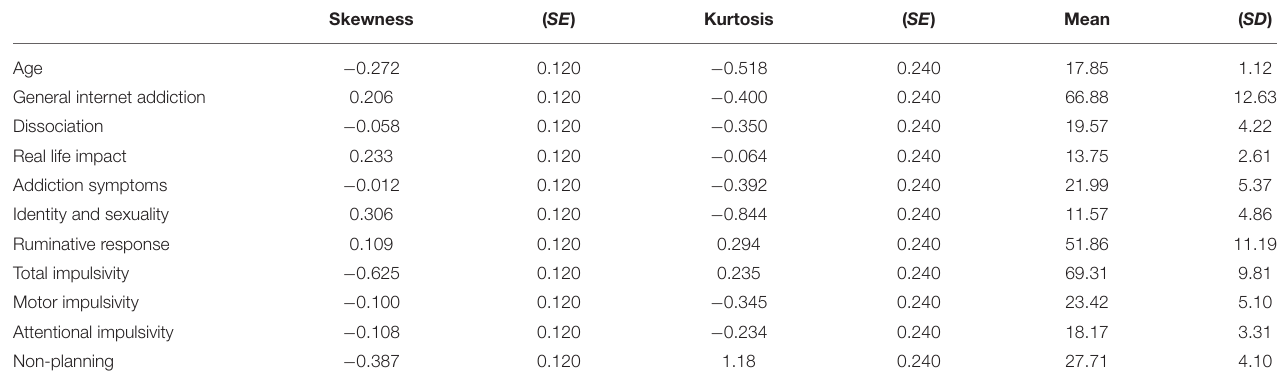
TABLE 3 | Descriptive values of the variables.